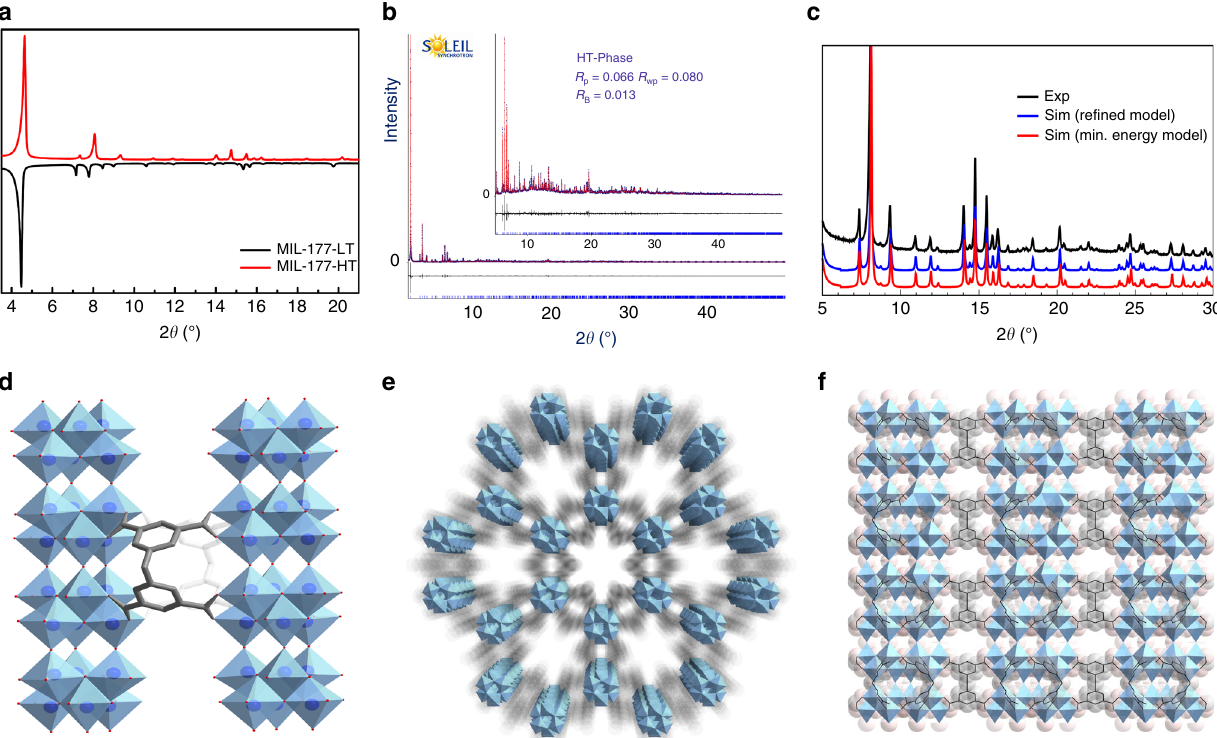
Fig. 4 Structural characterization and detail of MIL-177-HT. a PXRD comparison between MIL-177-LT and HT compounds. b . Final Rietveld plot of MIL-177-HT structure. c Comparison of the PXRD patterns obtained from experimental data, theoretically derived minimum energy structure and re fi ned structure model of MIL-177-HT. d Adjacent in fi nite ultrathin (Ti 6 O 9 ) n nanowires with a thickness of ca. 1 nm connected by mdip linkers (in gray). e Channels between the (Ti 6 O 9 ) n nanowires array running along the c -axis with a diameter of ca. 0.9 nm. f Small channels of 0.3 nm windows retained when viewed along the b -axis of the MIL-177-HT crystal structure